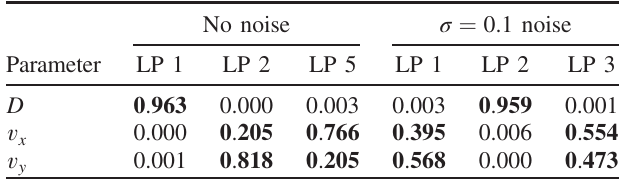
TABLE II. R 2 correlation coefficients from individual linear fits of the 2D convection-diffusion dataset parameters with each relevant latent parameter (LP). High correlations are in bold font, emphasizing the interpretability of the learned latent parameters as either corresponding to the diffusion constant D or the drift velocity components v , v . The drift velocity is matched with x y two latent parameters that form a two-dimensional latent sub- space corresponding to the velocity vector.